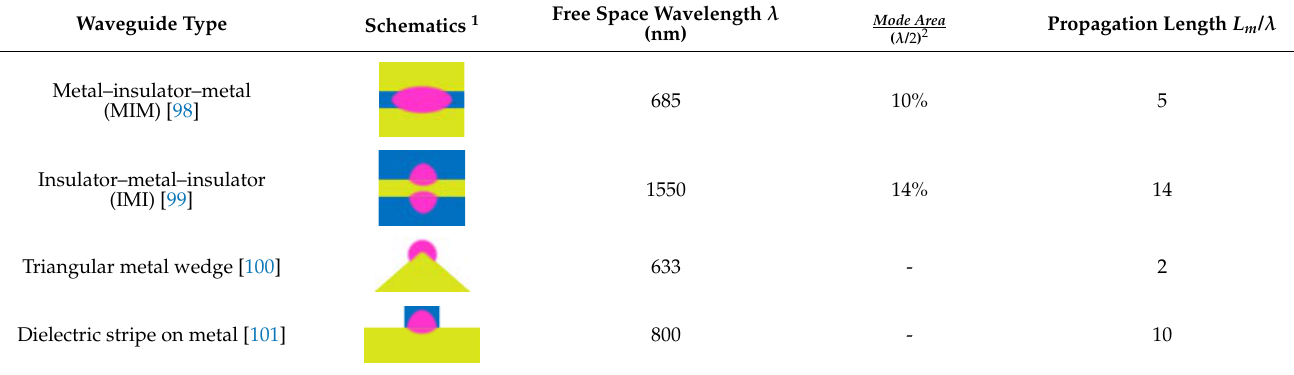
Table 2. Attenuation of several types of plasmonic waveguides reported in literature by experiments. Waveguide